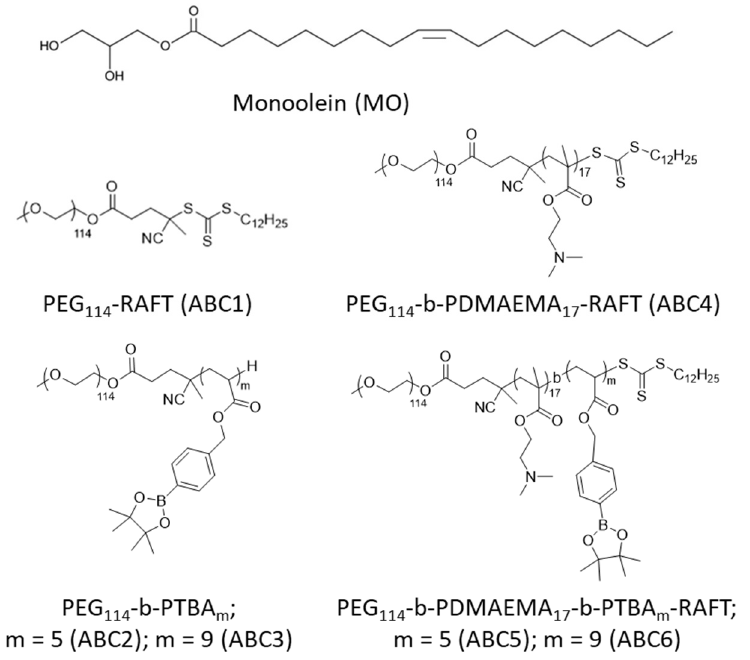
Figure 2. Chemical structures of MO and the synthetic ABCs used in the study.